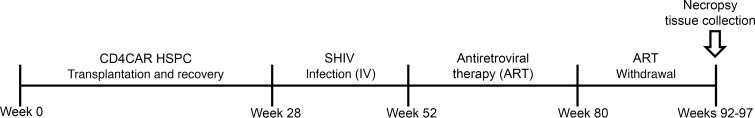
Study schematic for CAR 1, CAR 2, Control 1, and Control 2 animals.A total of 4 pigtail macaques were transplanted with autologous HSPCs modified to express CD4CAR (n = 2) or a control CD4CARΔζ (n = 2), which lacks intracellular signaling function but retains the extracellular domain for immunolabeling. Following 28 weeks of posttransplant recovery, animals were infected with SHIV-1157ipd3N4 via the i.v. route. Approximately 6 months later, antiretroviral therapy (ART) was initiated, then withdrawn 28 weeks later, in order to compare the persistence of CD4CAR and control-modified cells in low- and high-antigen conditions, respectively. Following ART withdrawal, animals were monitored for approximately 15 weeks prior to necropsy.